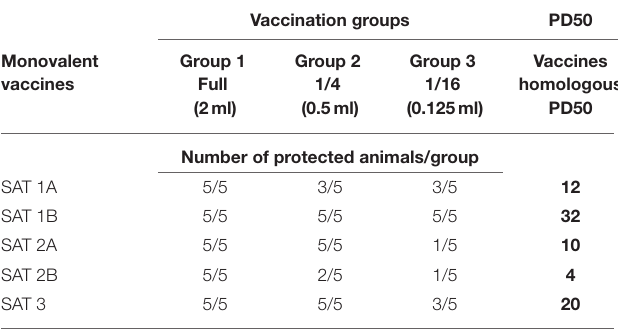
TABLE 4 | Monovalent vaccines PD50 post-homologous virus